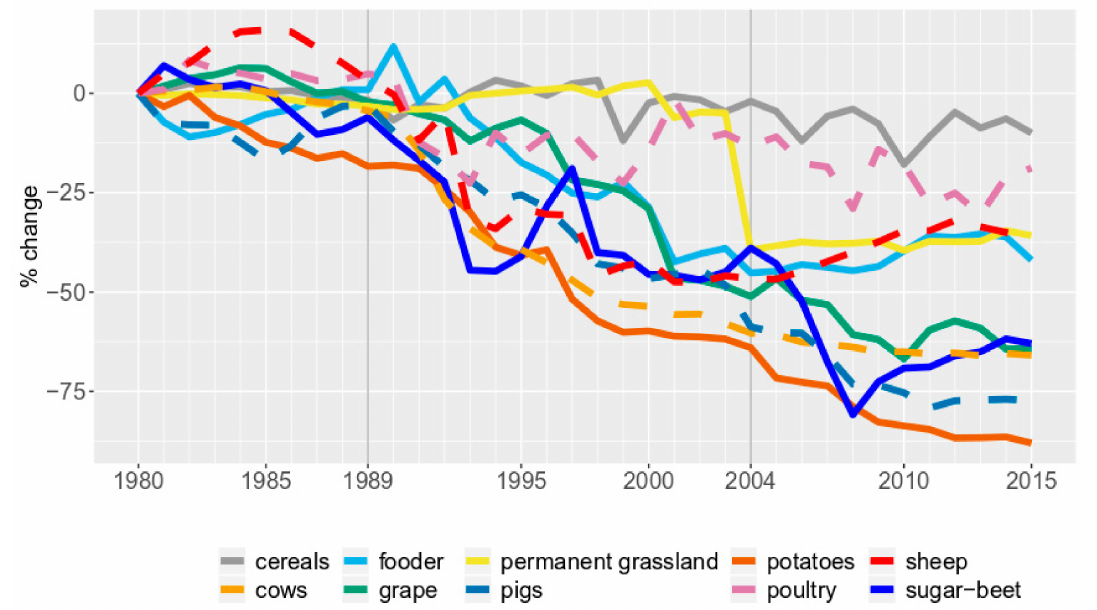
Figure 2. Relative change in crop yields (solid lines) and livestock numbers (dashed lines) from 1980 to 2015. The vertical grey lines indicate the years of the fall of socialism and accession to the European Union. Source: Statistical O ffi ce of the Slovak